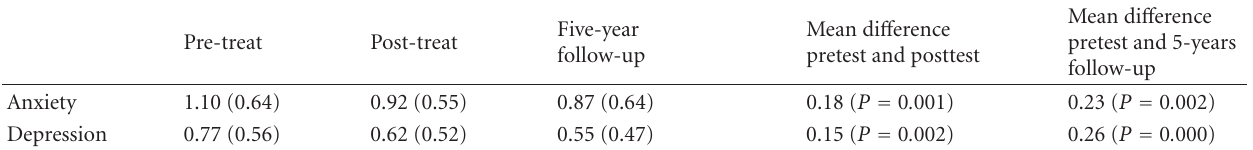
Table 2: Mean scores and standard deviation regarding anxiety and depression at pre- and posttreatment and after 5 years of follow-up ( n = 68).